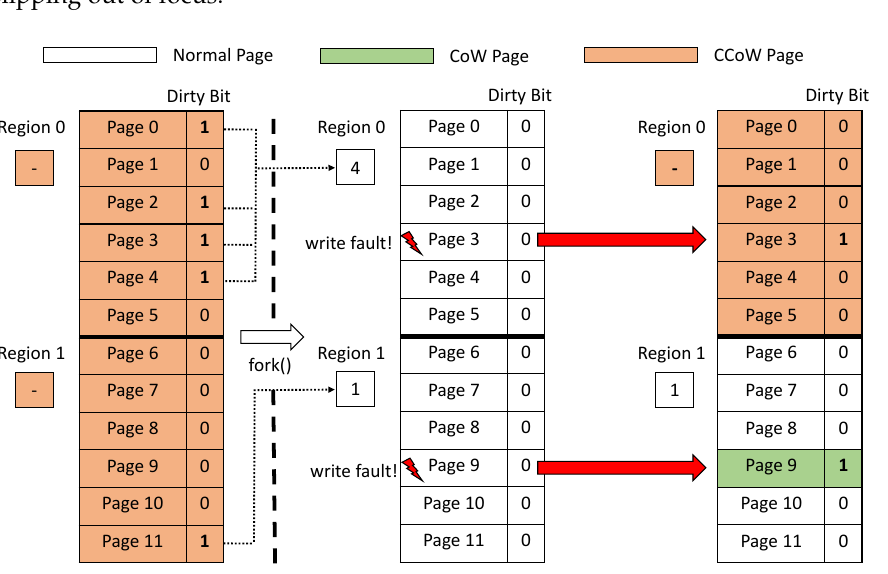
Figure 2. Processing fork and page faults in precopied